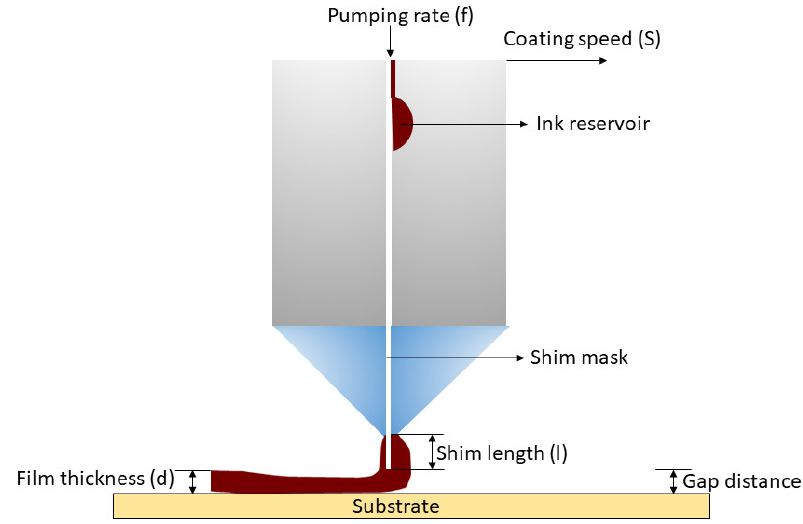
Figure 4. Slot-die coating head and the ink ejection process .